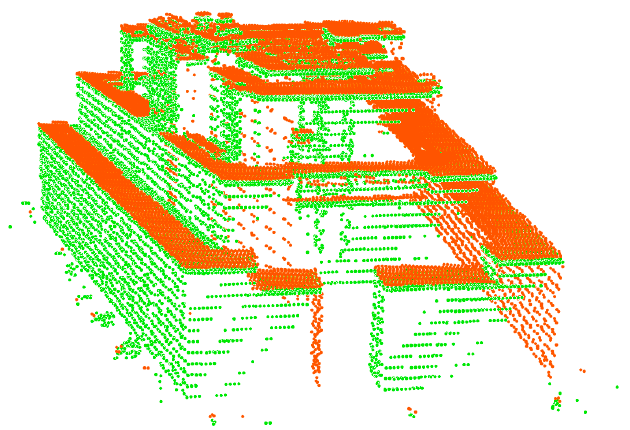
Figure 8. Visualization of the local building’s point cloud after registration.